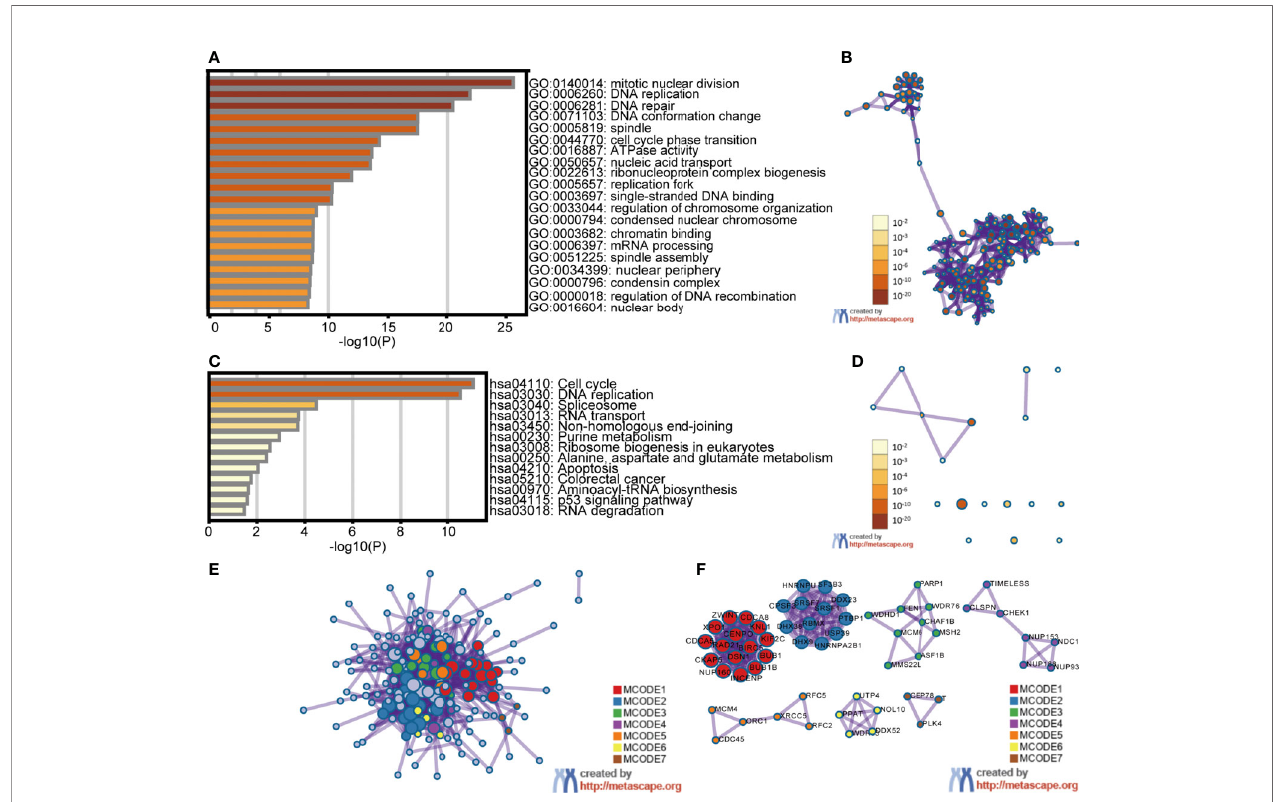
FIGURE 7 | Enrichment analysis of E2Fs and the genes similar to them in STAD patients (Metascape). The top 30 similar genes of each E2F family member in STAD were identi fi ed using the GEPIA2 datasets. The Metascape was used to perform Gene Ontology (GO) and Kyoto Encyclopedia of Genes and Genomes (KEGG) enrichment pathway analysis of the E2Fs and similar genes. A subset of enriched terms was selected and rendered as network plots to further reveal the relationships between the enriched terms. A Protein-protein interaction (PPI) network was created using BioGrid, InWeb_IM, and OmniPath. In addition, the molecular complex detection (MCODE) algorithm was utilized to analyze clusters of the PPI network. (A) Heatmap of GO enriched terms colored by p -value. (B) Network of GO enriched terms colored by p -value, where terms containing more genes tend to have a more signi fi cant p -value. (C) Heatmap of KEGG enriched terms colored by p -value. (D) Network of KEGG enriched terms colored by p -value, where terms containing more genes tend to have a more signi fi cant p -value. (E) PPI network of genes similar to E2Fs. (F) MCODE components identi fi ed in genes similar to E2Fs.